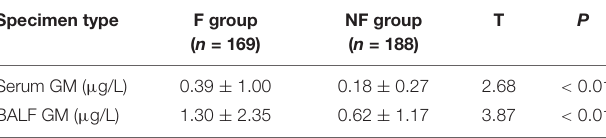
TABLE 1 | Characteristics of the patients.